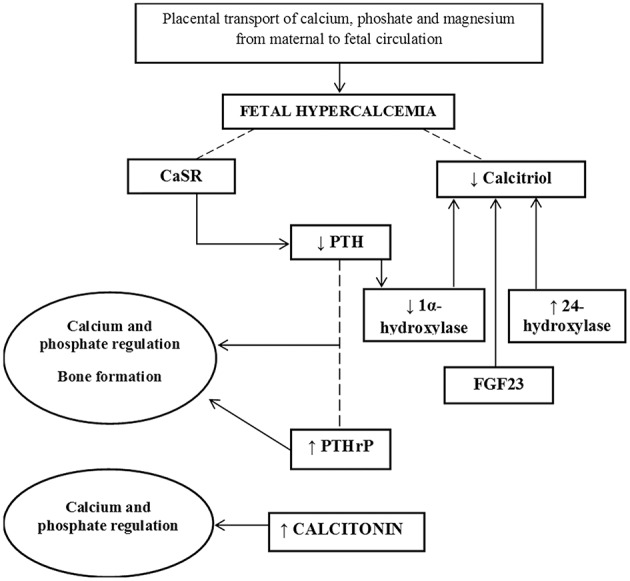
Diagram of mechanisms involved in fetal bone mineral accretion.